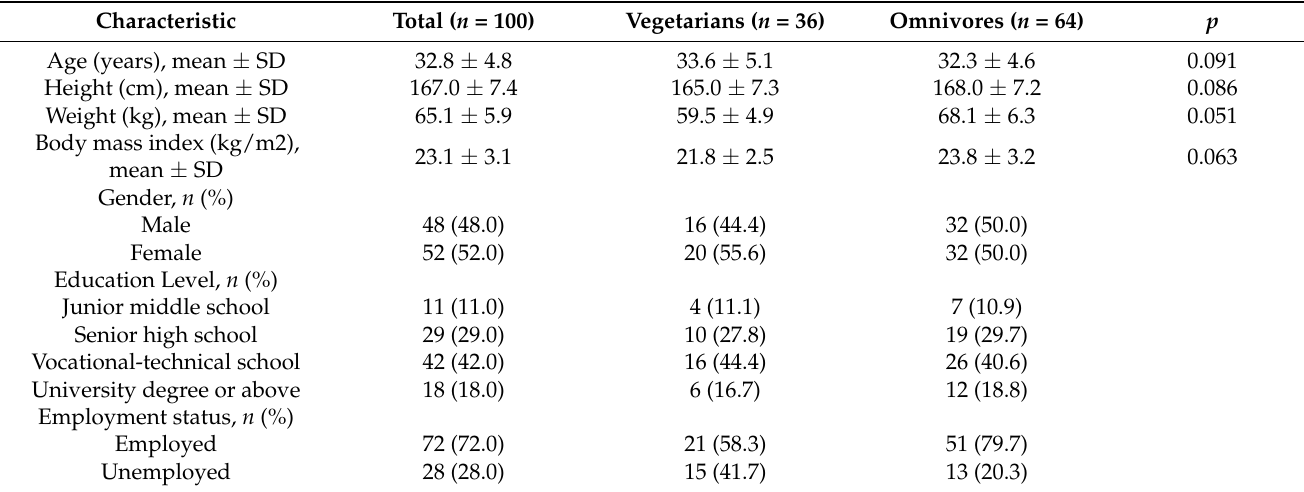
Table 2. Characteristics of participants in the